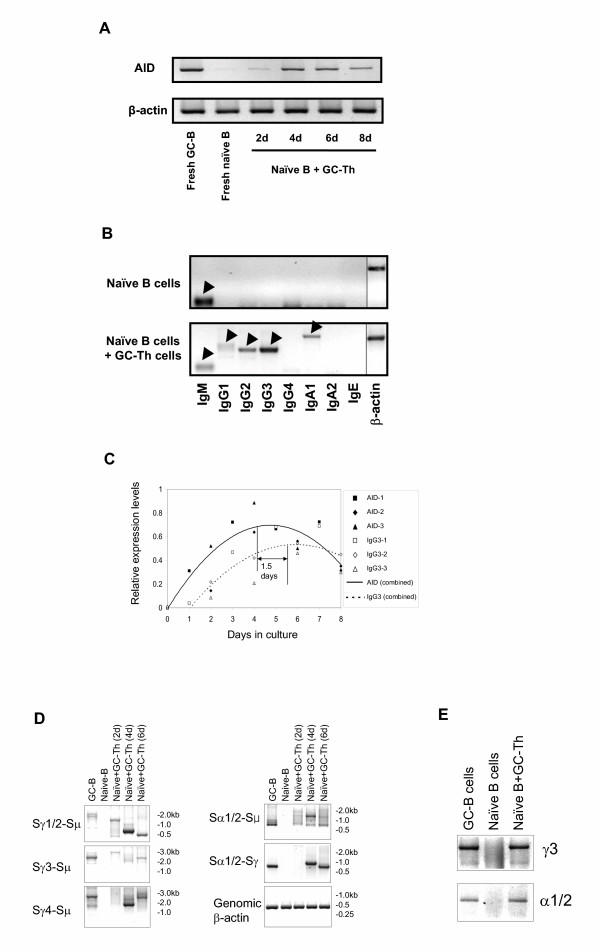
CD57+ GC-Th cells have the capacities to induce AID expression and to support CSR in B cells. IgD+CD38- naïve B cells were cultured with CD57+ GC-Th cells for indicated time periods followed by RT-PCR analysis for (A) AID expression and (B) CSR. The sizes of specific PCR products are 152 bp (IgM); 416 bp (IgG1, G2, G3), 904 bp (IgG4); 904 bp (IgA1); 891 bp (IgA2); and 179 bp (IgE). Shown are productive recombination products. (C) The expression kinetics of AID and productive IgG3 transcripts over an 8 day period are shown together in a graph. In this panel, normalized expression levels calculated after dividing the levels of AID amplification by β-actin levels are shown. The time gap to reach the peak levels of the expression between AID and productive IgG3 transcripts is shown by an arrow. Representative data from at least three independent experiments are shown (panels A and B). (D) Identification of extrachromosomal reciprocal DNA recombination products. Naïve B cells were cultured with CD57+ GC-Th cells for indicated time periods and were processed to isolate genomic DNA. Fresh GC-B cells were examined for positive controls. The switch circles were detected by a nested PCR method. Representative data out of three independent experiments are shown. (E) Detection of switch circles by a DC-PCR technique. Naive B cells, CD38+ GC-B cells and naïve B cells cultured with GC-Th cells for 5 days were examined for the presence of γ3 and α1/2 switch circles.